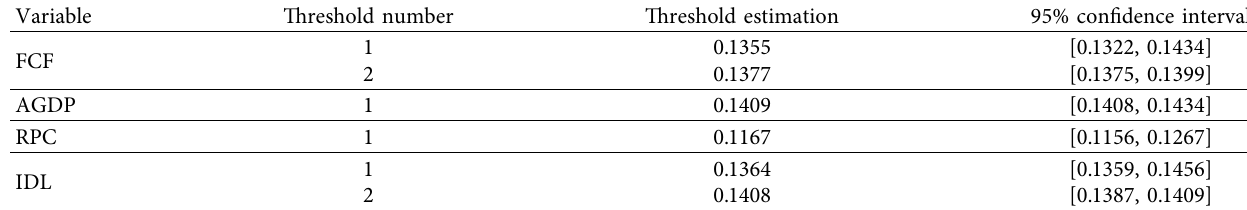
Table 6: Threshold estimation and confidence interval.